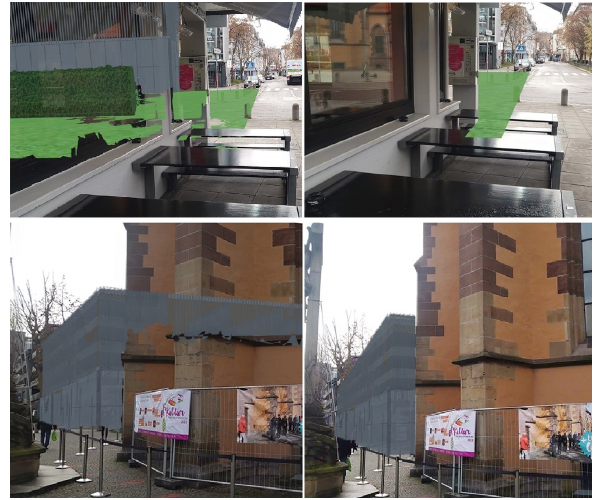
Figure 8. Comparison between occlusion screening based on ( left ) the Spatial Map and ( right ) the 3D building model.